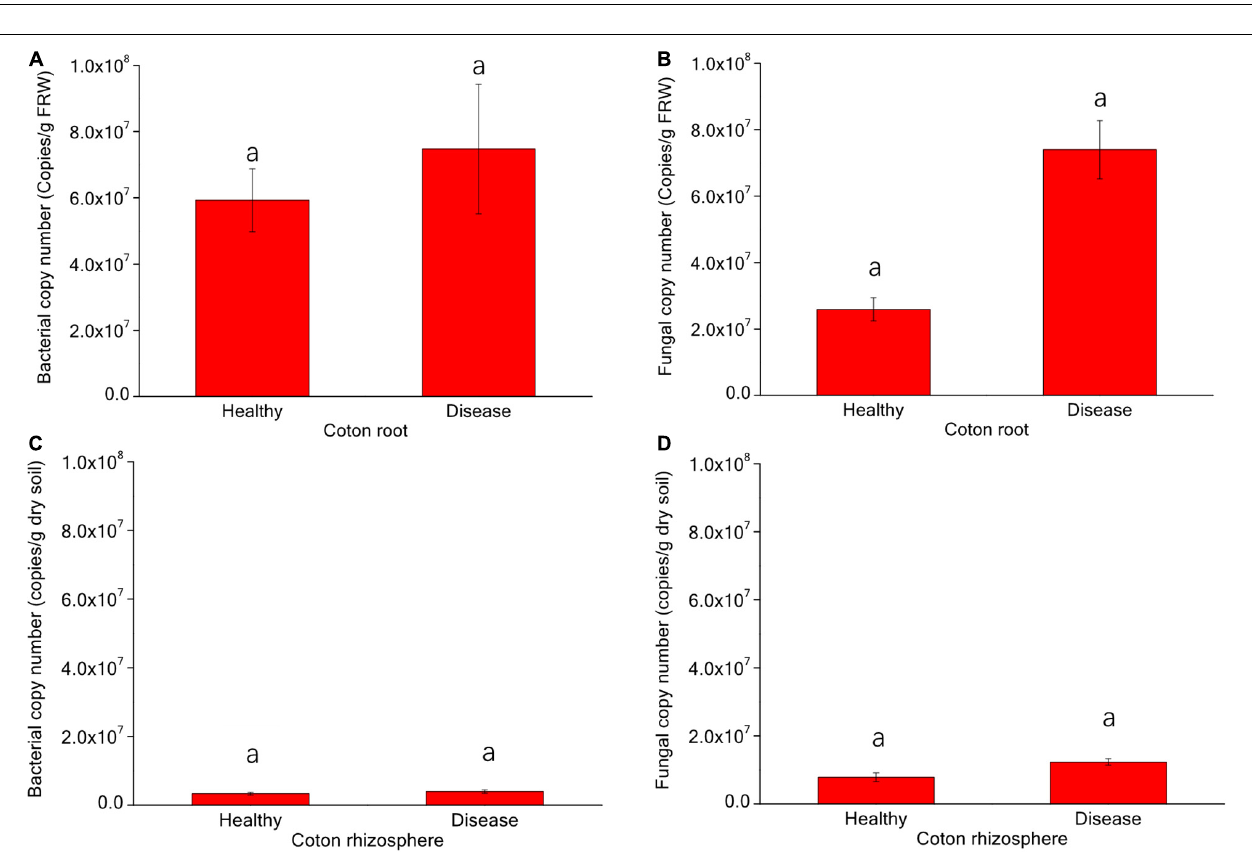
FIGURE 1 | The number of OTUs of rhizosphere and endophytic bacteria (A) and fungi (B) in healthy and diseased cotton ( P < 0.05).